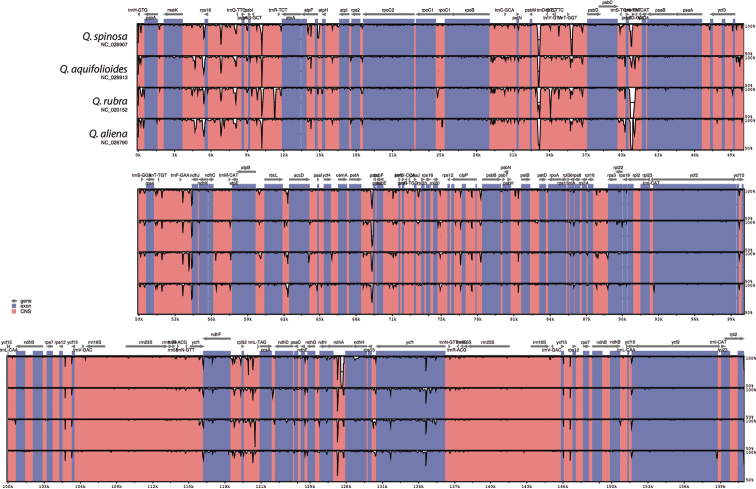
mVISTA percent identity plot comparing the four Quercus chloroplast genomes with Q.
xanthoclada as a reference. Vertical scale indicates the percentage of identity ranging from 50% to 100%. Coding regions are in blue and non-coding regions are in pink.